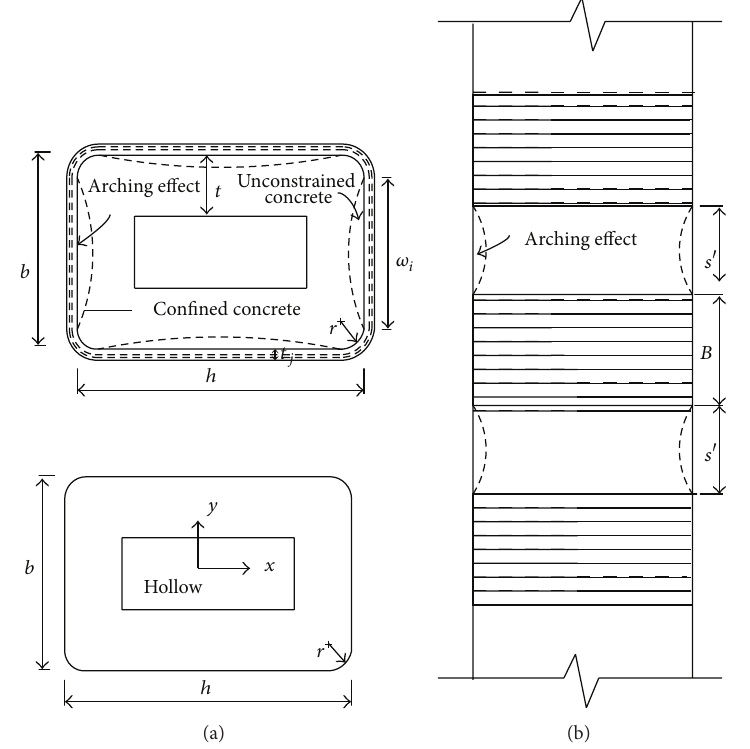
Figure 7: Arching effect of section (a) cross section and (b) longitudinal